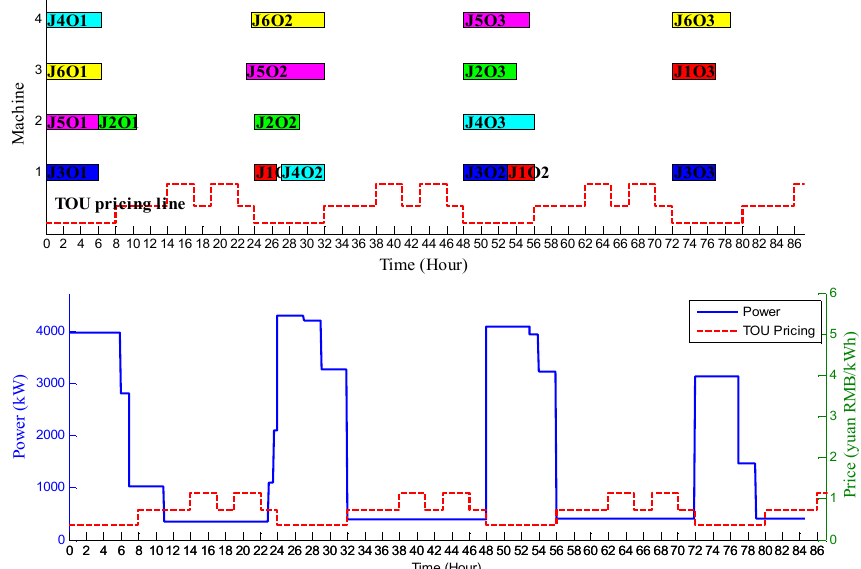
Figure 14. Gantt and power charts of the optimal solution to configuration C4 × 6&EDF&EIE.